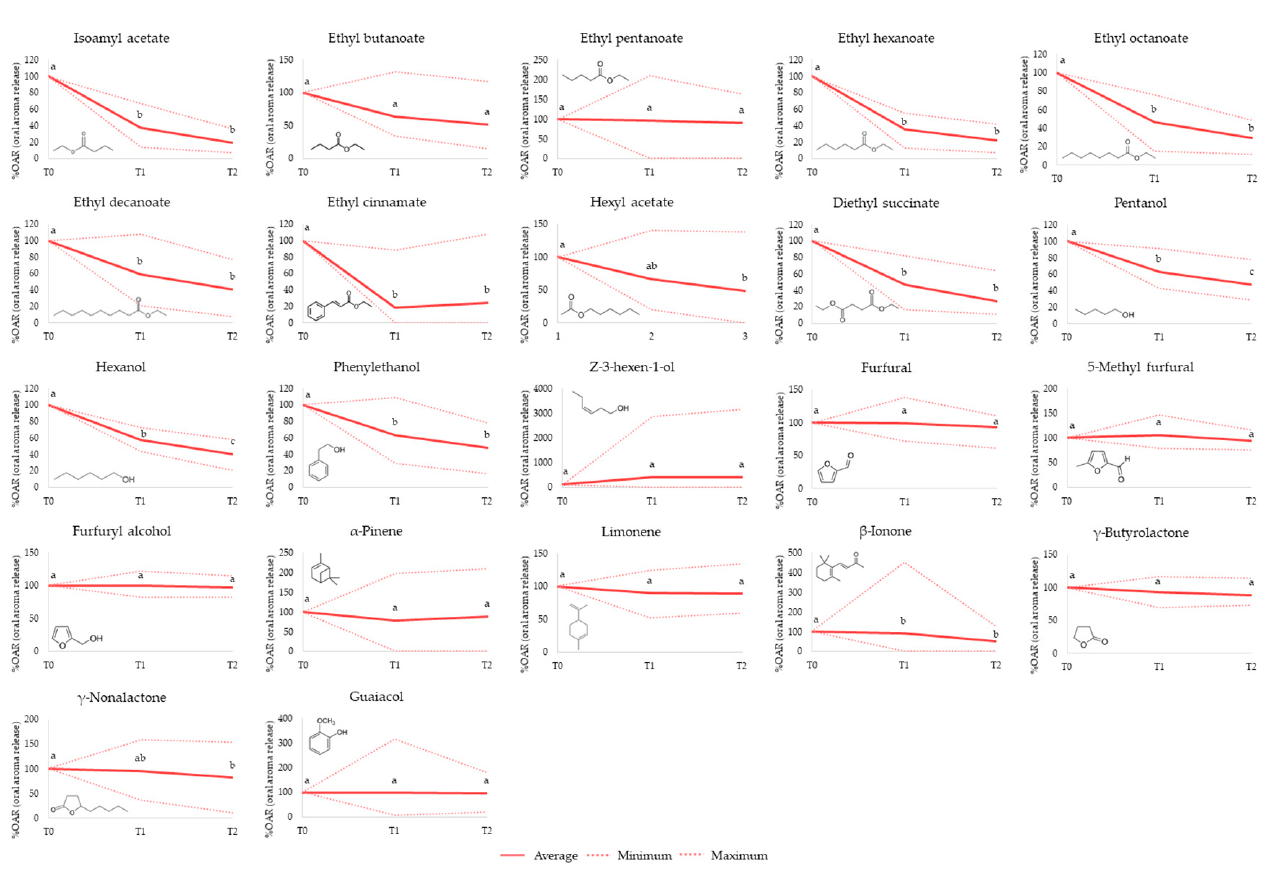
Figure 2. Oral aroma release profiles (%OAR) of 22 wine aroma compounds at 0 (T1), 60 (T2), and 120 (T3) seconds after of wine expectoration. The solid line shows the average value, while the dotted lines show the maximum and minimum values from three repetitions from the same wine and 32 volunteers ( n = 96). Different letters above the points denote different significance level ( p < 0.05) from the Tukey